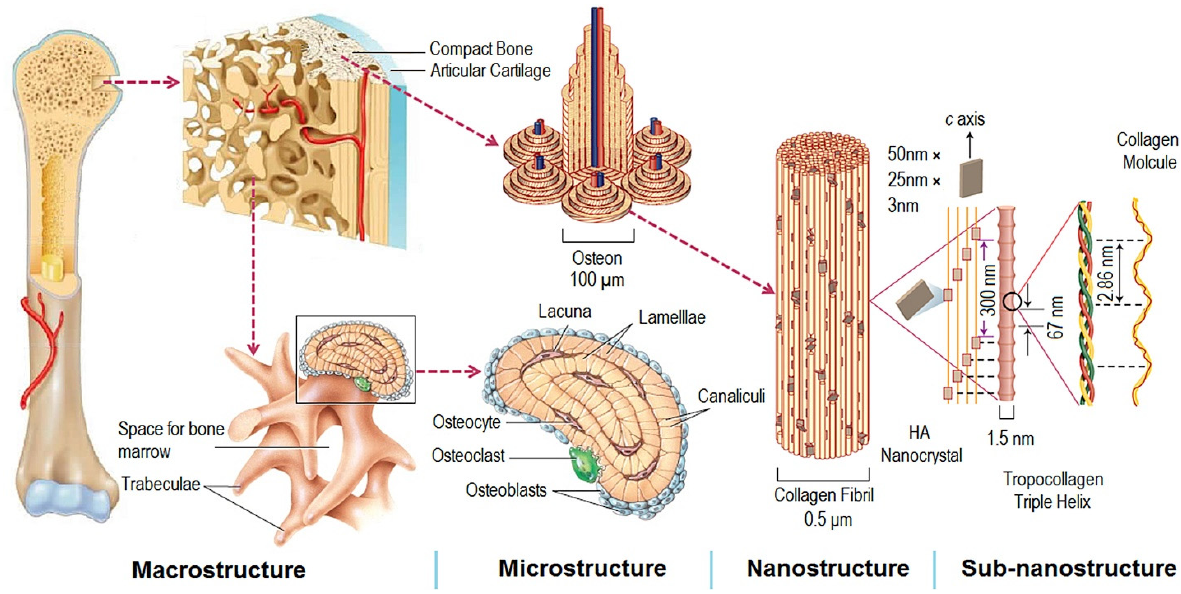
Figure 1. Structural levels of bone from macro to subnanometer scale. Reprinted with permission from ref. [17]. 2016, Elsevier Ltd.